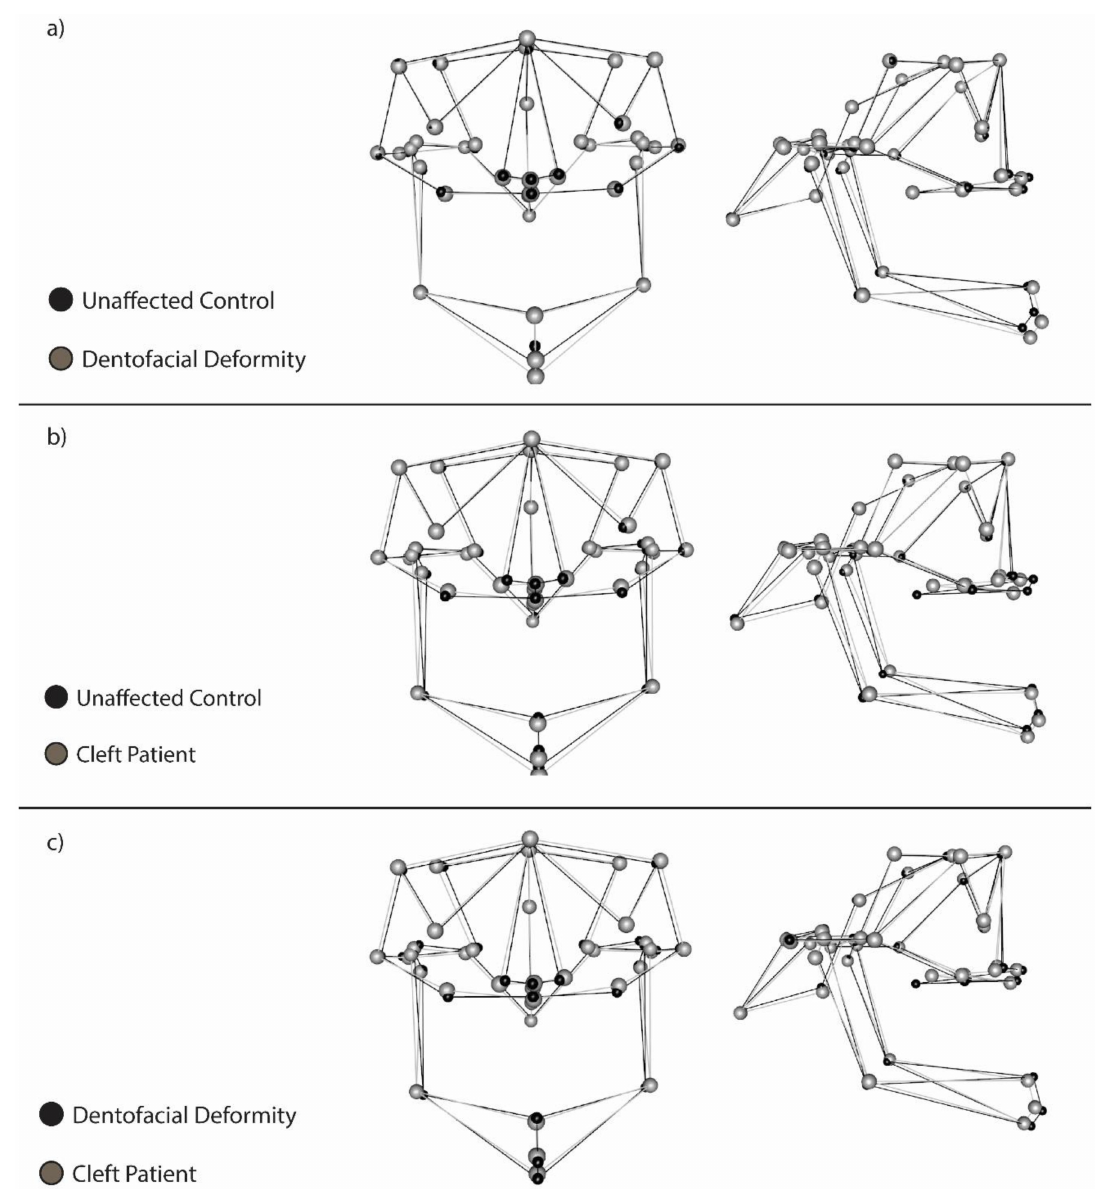
Figure 3. Pairwise wireframe overlays comparing mean craniofacial shape of each cohort. Frontal and sagittal views are presented. All pairwise comparisons are shown: ( a ) una ff ected controls compared to patients with dentofacial deformities; ( b ) una ff ected controls compared to patients with clefts; ( c ) patients with dentofacial deformity compared to patients with clefts. Both dentofacial deformity and nsCLP cohorts vary from the una ff ected control group in a similar fashion ( a , b ) with maxillary hypoplasia / retrognathia and mandibular hyperplasia / prognathia. The third wireframe, ( c ), shows that the dentofacial deformity and nsCLP group are highly comparable in shape despite the presence of a cleft in one group. The mandible shape is also a ff ected in the nsCLP. It is important to note that the maxilla in the nsCLP is deficient even in areas distant from the cleft site, i.e., right and left jugal points and is generally more hypoplastic but wider than the dentofacial deformity group. Landmarks are indicated by dots and a greater distance between dots in the two cohorts indicates di ff erences in shape at that location between the two cohorts. The lines connecting dots are provided to better indicate overall skull shape and